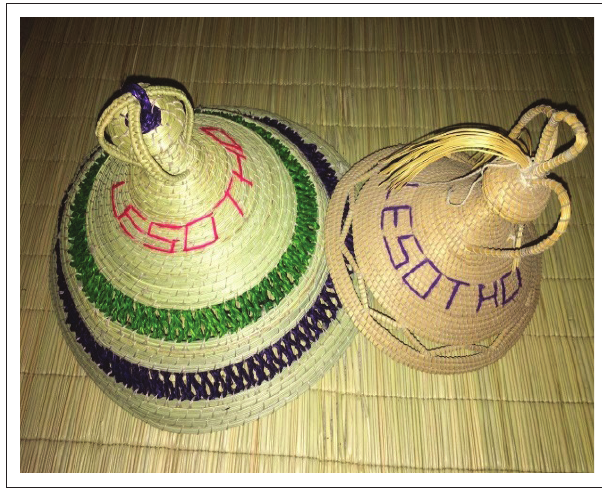
Source : Photo taken by the author. FIGURE 3: Mokorotlo and modiyanyeo – Basotho hats – sold by respondents.